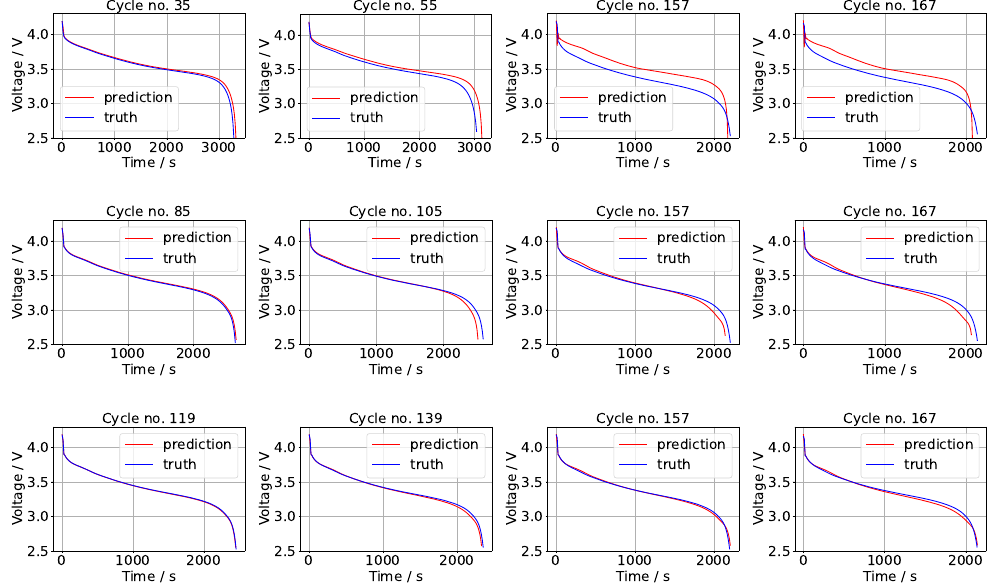
Figure 3. Voltage results for the data set B0006 for different numbers of training points. From the top row to the bottom row, 20%, 50% and 70% of the data is used.